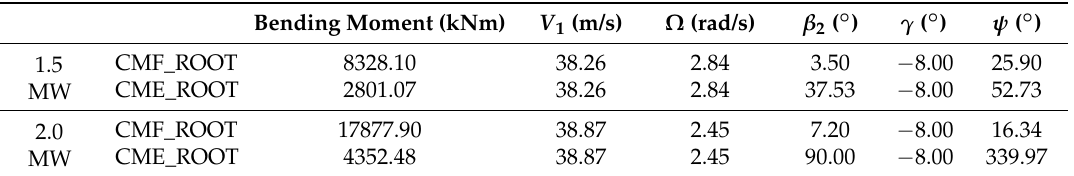
Table 3. Extreme bending moments and their corresponding status parameters without considering the constraint conditions about the